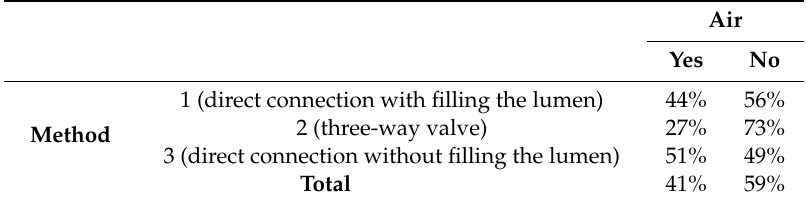
Table 3. Air in the balloons depending on the method.